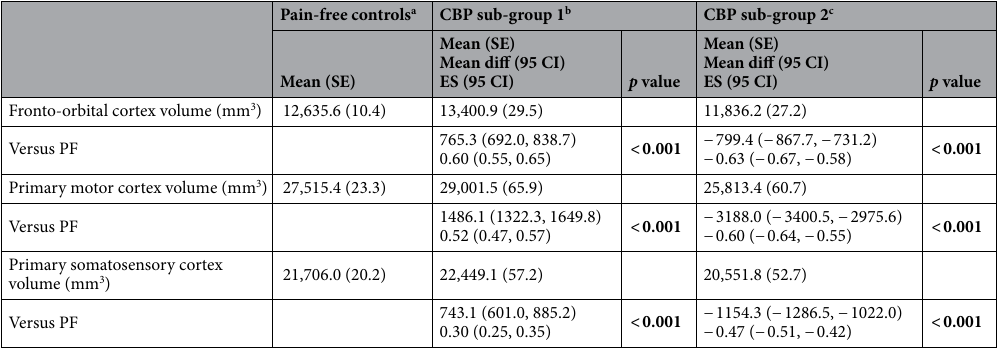
0.716 in the test data (Supplementary Tables 14 and 15). The discrimination values ranged from − 0.29 to − 1.16 in the training data clusters and − 0.29 to − 1.14 in the test set clusters (Supplementary Tables 14 and 15). For classification, the classification accuracy (range of AUC) for the validation set for SVM, Naïve Bayes, kNN and RF classifiers were > 99% (1.00–1.00), 63.6% (0.58–0.99), 92.3% (0.95–0.99) and > 99% (1.00–1.00), respectively (Supplementary Table 16; Supplementary Figures 64 and 65). For the test data the results SVM, Naïve Bayes, kNN and RF classifiers were 97.9% (0.99–1.00), 62.9% (0.56–0.99), 89.9% (0.94–0.98) and 98.4% (0.99–1.00) (Supplementary Table 16; Supplementary Figures 66 and 67). Outside of Naïve Bayes classification, this shows similar clustering a classification results to the main analyses (Supplementary Table 16; Supplementary Figures 64 and 66). Calibration curves are reported in Supplementary Figures 68–71 and calibration metrics are reported in Supplementary Table 6. The results of prior probably adjusted classification models are in Supplementary Table 17. For classifiers testing CBP individuals, no major differences were observed between original and prior probability adjusted